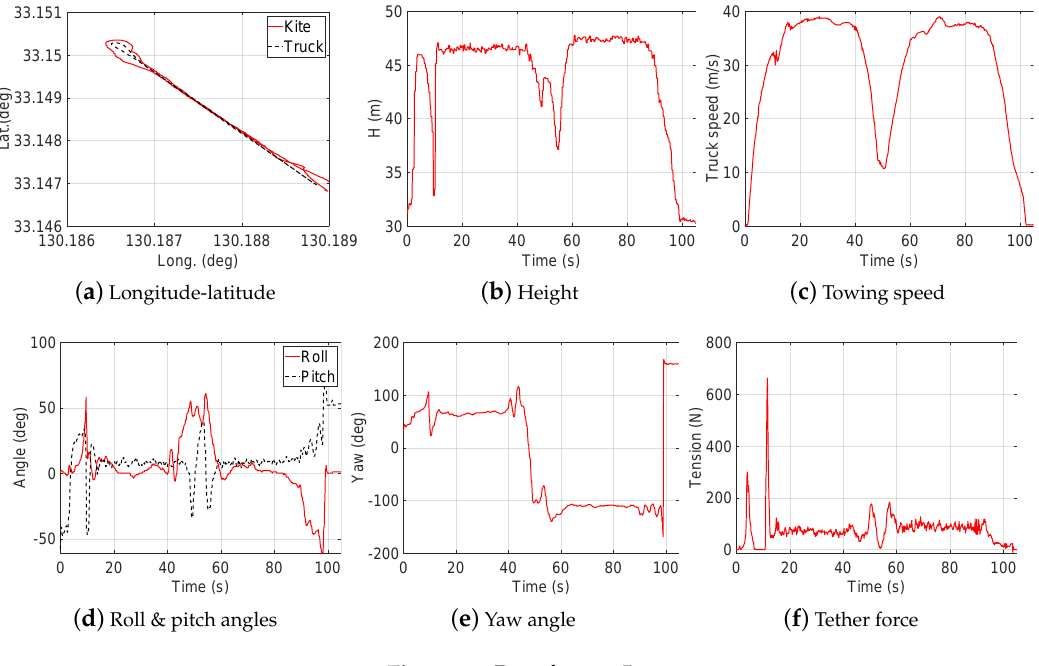
Figure 15. Data for test 5.